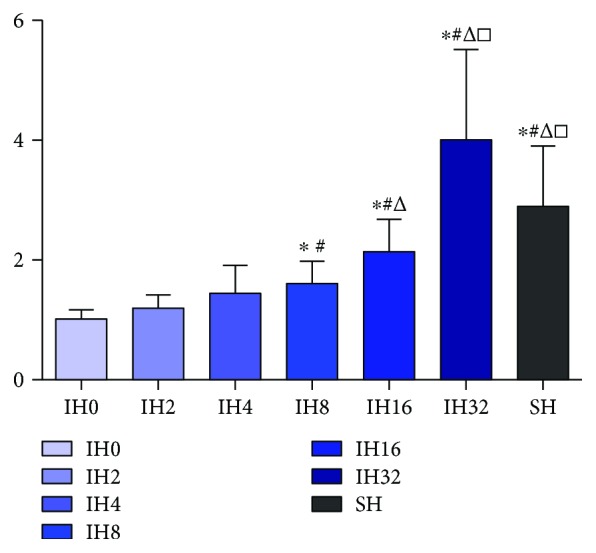
Effect of different numbers of IH cycles on SREBP-1c mRNA expression (n = 9) (compared with IH0 ∗P < 0.05, compared with IH2 #P < 0.05, compared with IH4 △P < 0.05, and compared with IH8 □P < 0.05.)